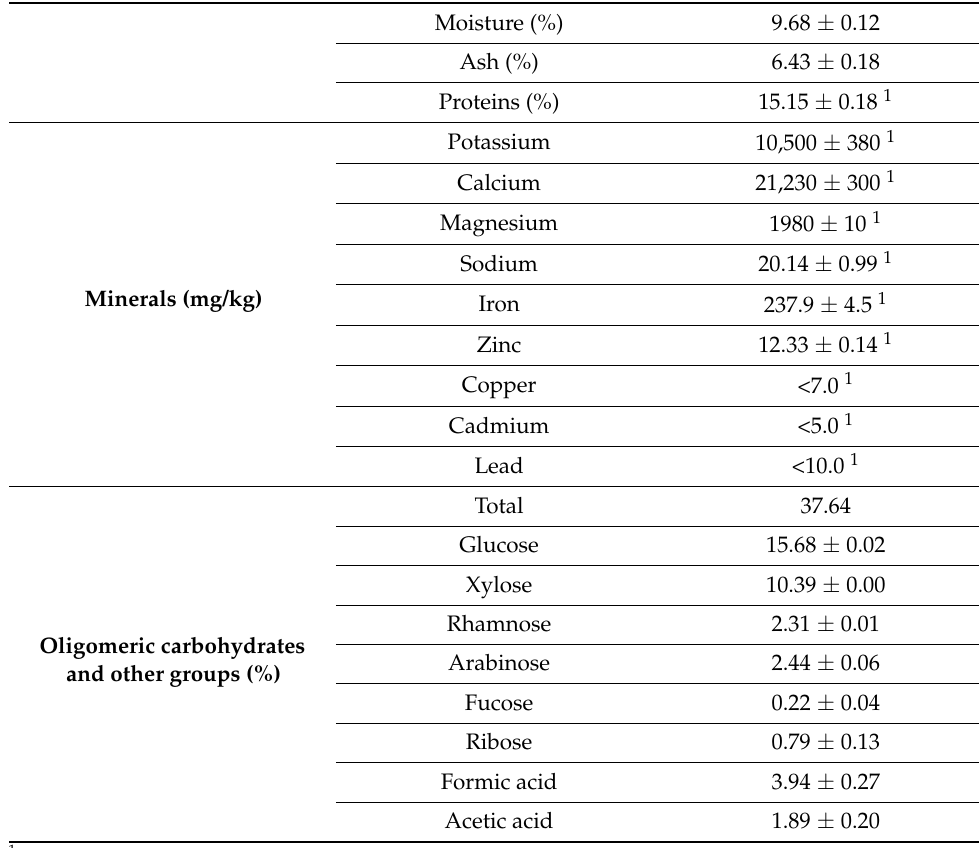
Table 1. Chemical characterization of A. chilensis dried leaves in db, except